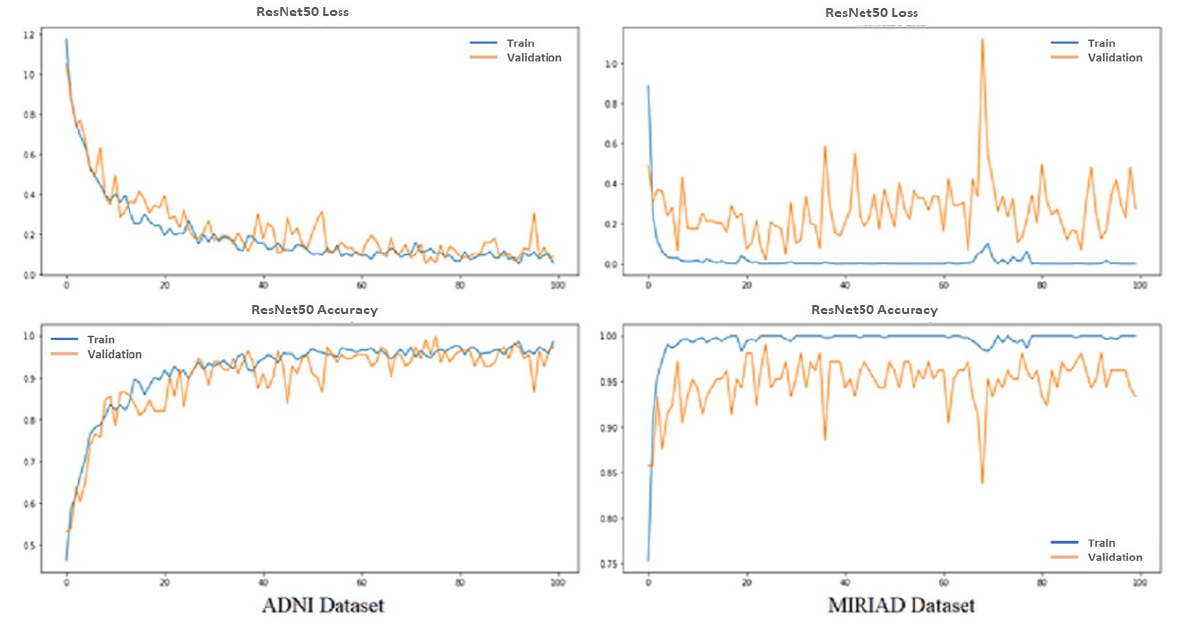
Figure 5. Training and validation performance of ResNet50-Softmax.